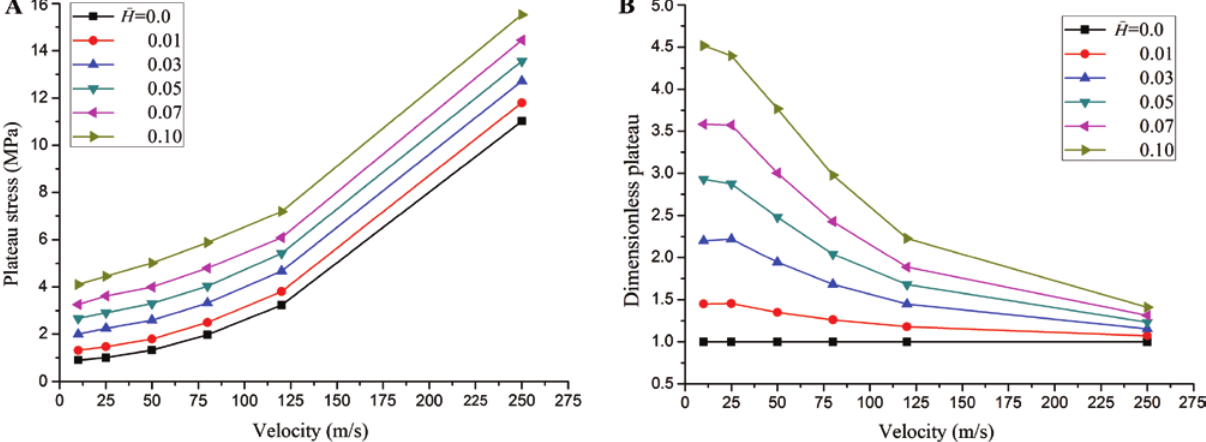
Figure 8: Plateau stress (A) and the dimensionless plateau (B) at the impact side.